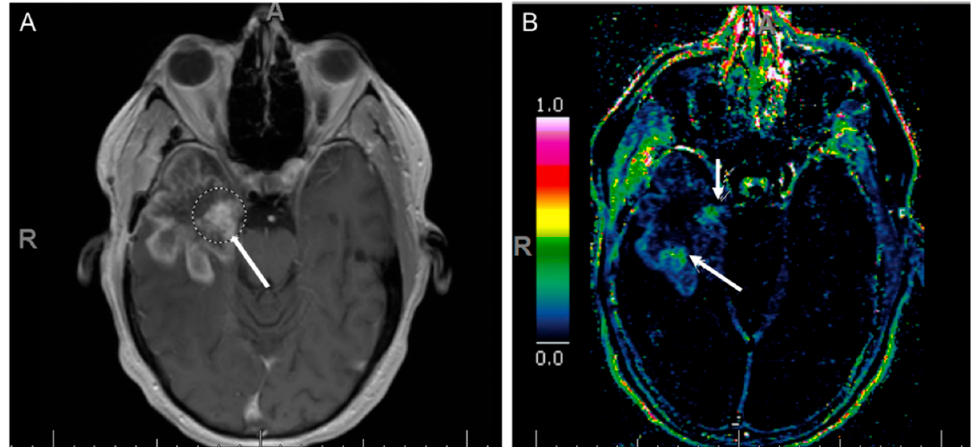
Figure 8. A patient with temporal glioblastoma underwent surgical resection followed by radiotherapy. ( A ) Axial T1 post ‐ contrast image of the brain shows nodular enhancement. ( B ) This